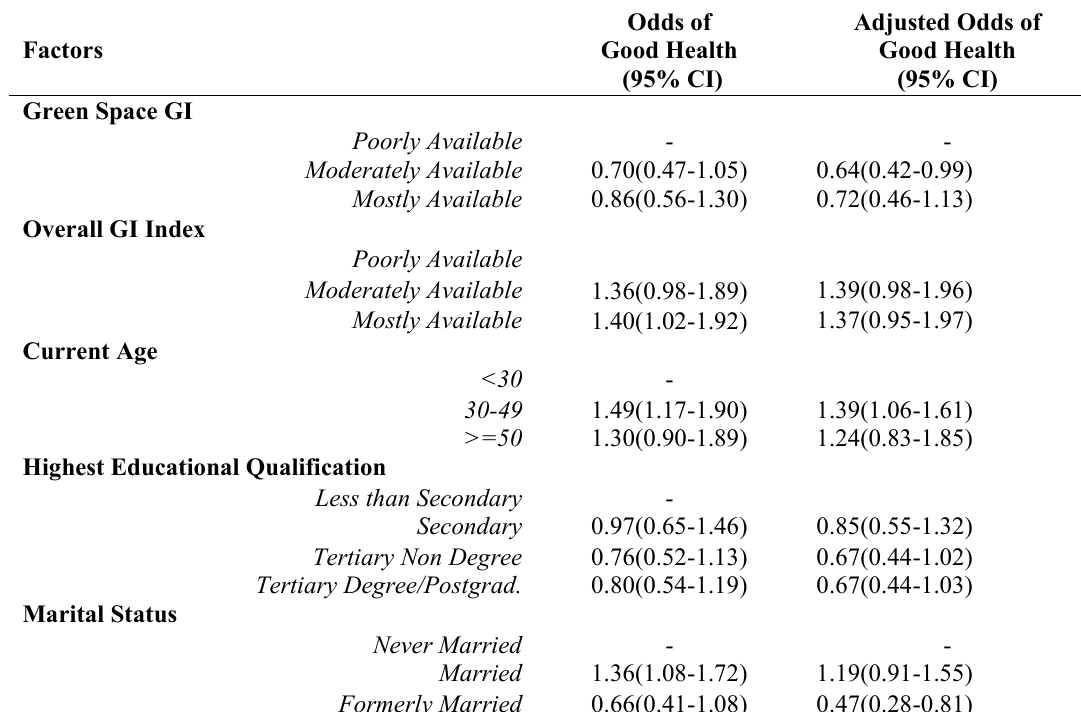
Table 3: Association of Green Infrastructure with Perceived Health benefit of GI